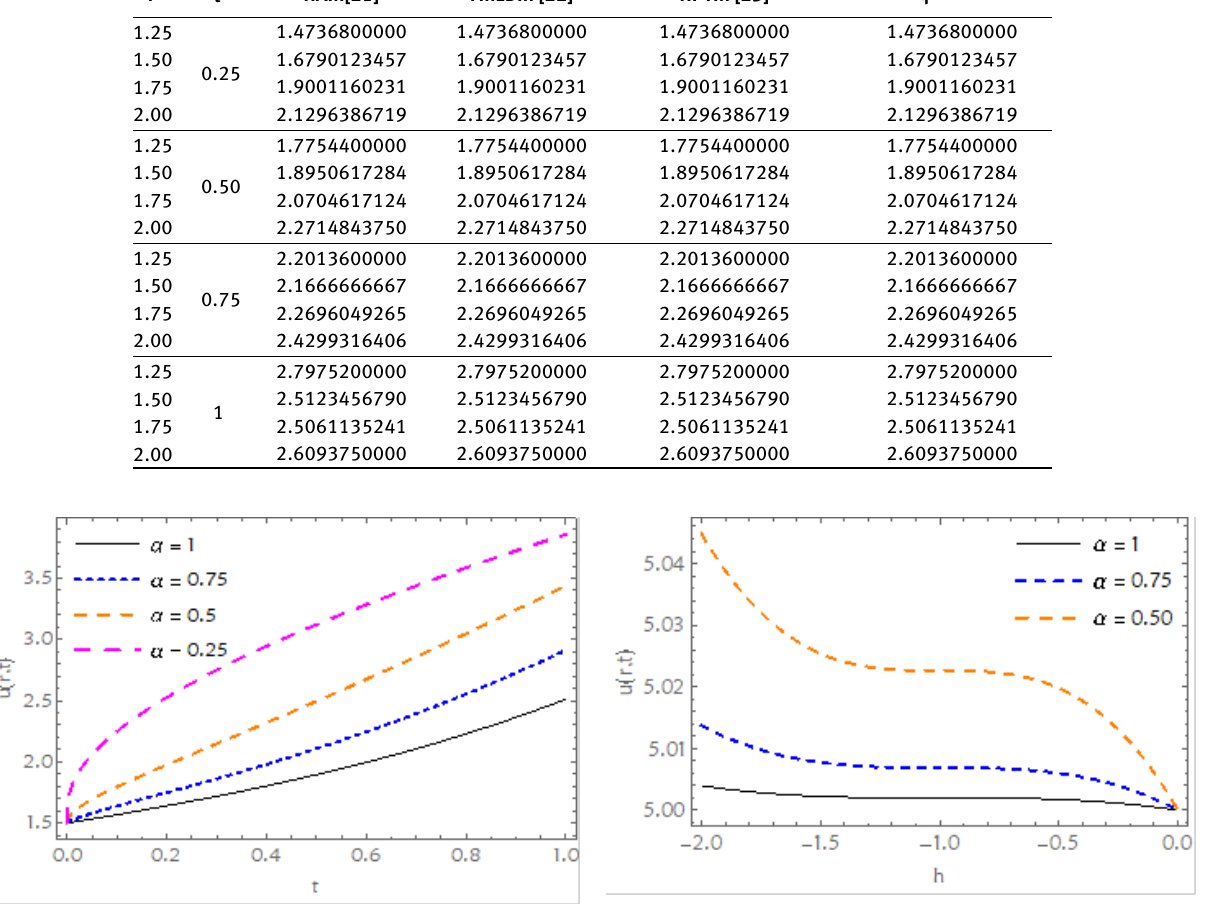
Table 1: Comparison of results by HAM, FMLDM, HPTM, q-HATM at different values of r and t when α = 1, (cid:126) = −1, n = 1 for Ex. 4.1.